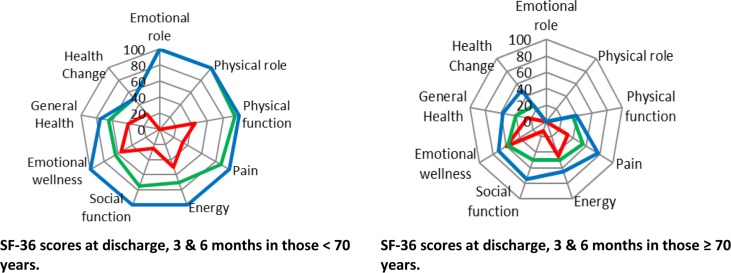
SF-36 scores at hospital discharge (red line) and 3 months (green) and 6 months (blue) after discharge. The figure shows different domains: physical functioning, bodily pain, role limitations due to physical health problems, role limitations due to personal or emotional problems, emotional well-being, social functioning, energy/fatigue, general health perceptions and single-item perceived change in health. The left panel shows scores in those <70 y of age and the right panel shows scores in those ≥70 y of age.